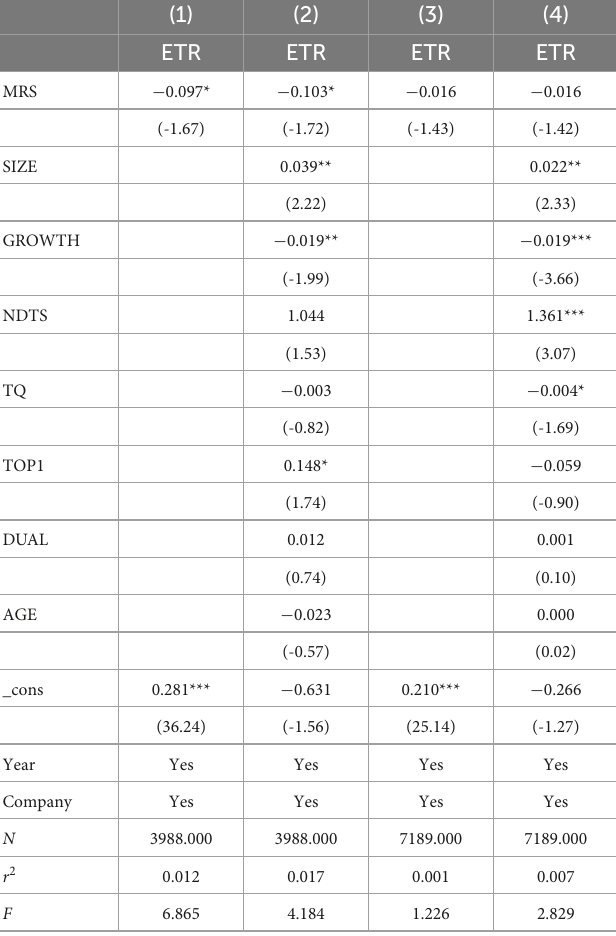
TABLE 9 Robustness test results of the effect of ownership type on the relationship between executive equity incentive and corporate tax